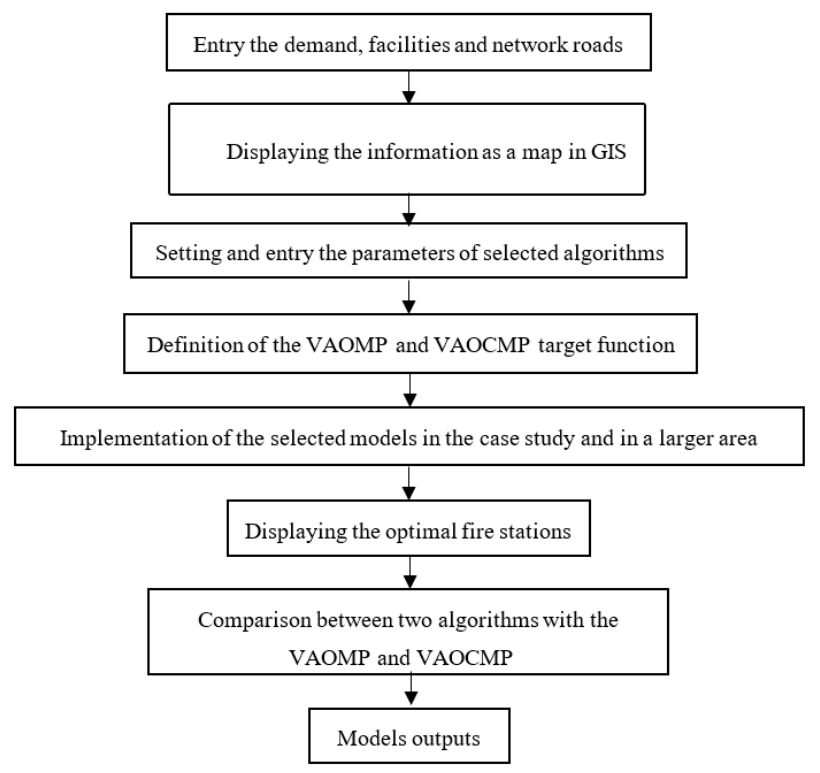
Figure 1. Implementation steps. VAOMP, Vector Assignment Ordered Median Problem; VAOCMP, Vector Assignment Ordered Capacitated Median